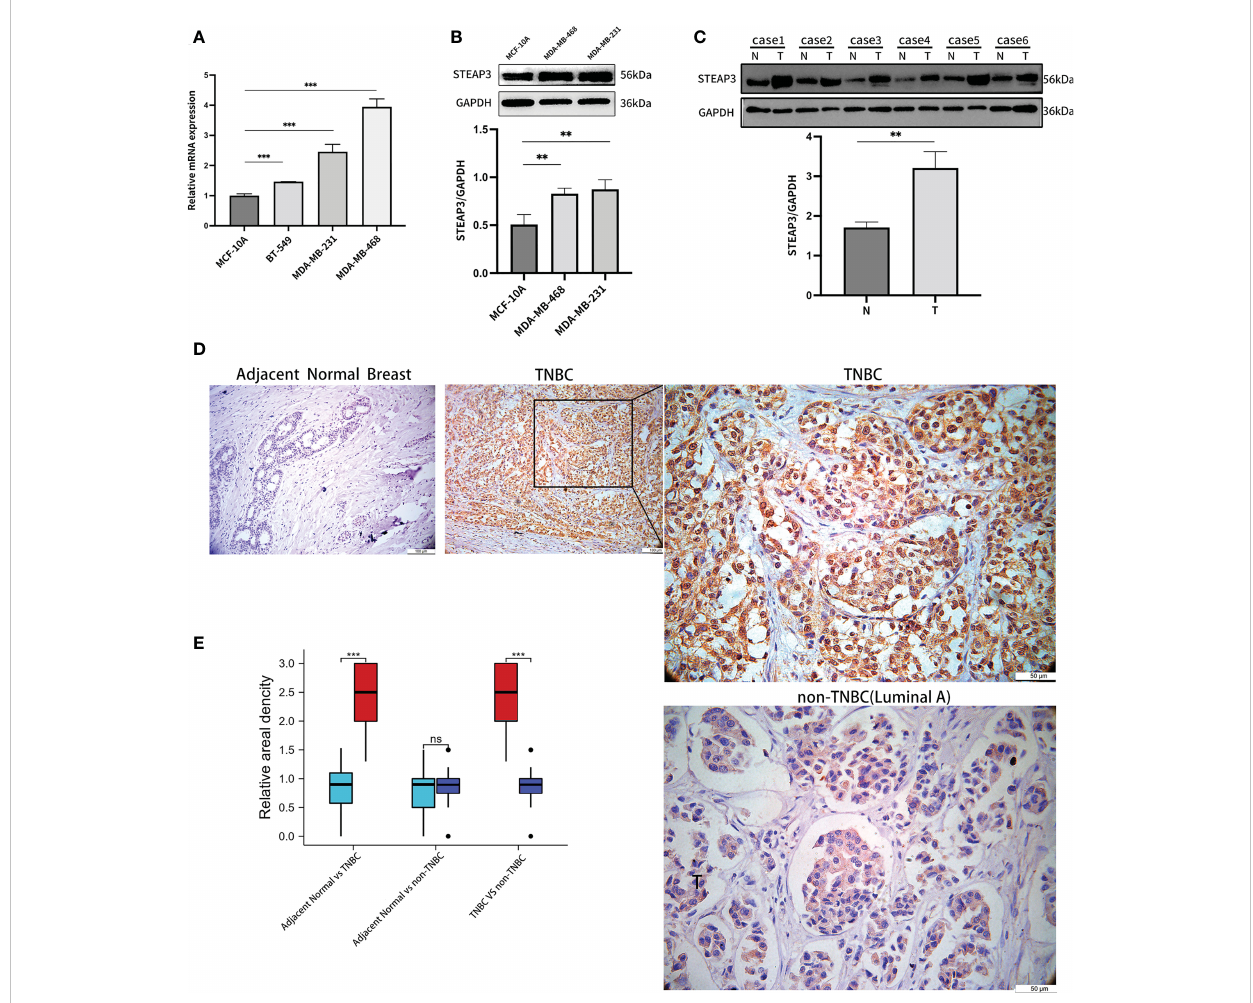
FIGURE 8 Validation of STEAP3 expression in breast cancer cell lines and tissue samples. (A) STEAP3 mRNA levels were assessed in the control MCF-10A cell line and the MDA-MB-231, BT-549, and BT-468 TNBC cell lines. (B, C) STEAP3 levels were detected via Western immunoblotting in the MCF-10A, MDA-MB-468, and MDA-MB-231 cell lines and in six pairs of TNBC (T) and adjacent normal (N) tissue samples from patients. (D) Representative IHC staining results for STEAP3 in adjacent normal tissues (Scale bar: 100 m m) and TNBC samples (Scale bars:100 m m and 50 m m), and non-TNBC(Luminal A) samples (Scale bar: 50 m m). (E) Quantitative data from IHC staining results for STEAP3 expression in 23 TNBC vs adjacent normal breast,12 non- TNBC vs adjacent normal breast and 23 TNBC vs 12 non-TNBC are shown. (**P<0.01, ***P< 0.001, ns